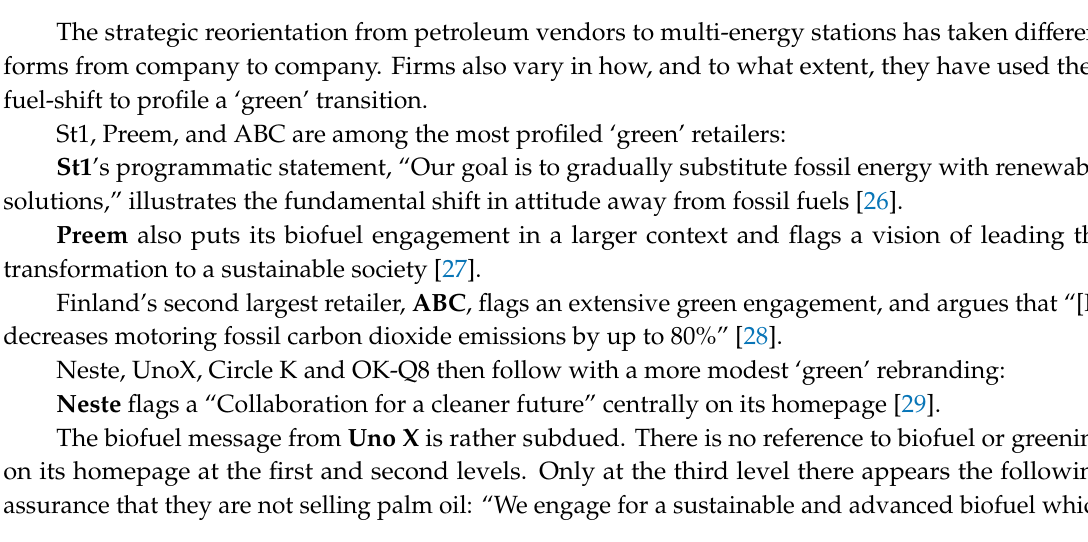
Figure 1. Fuel sales in Scandinavia. Source: [16–25].